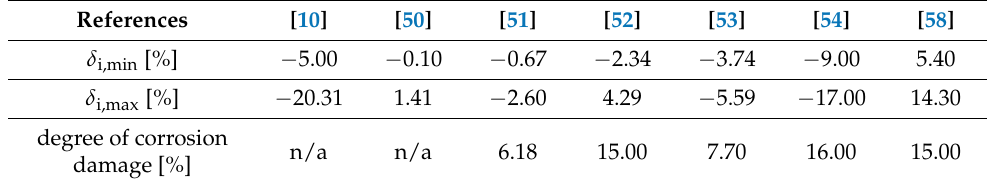
Table 3. Comparison of minimum and maximum values of change of natural frequencies